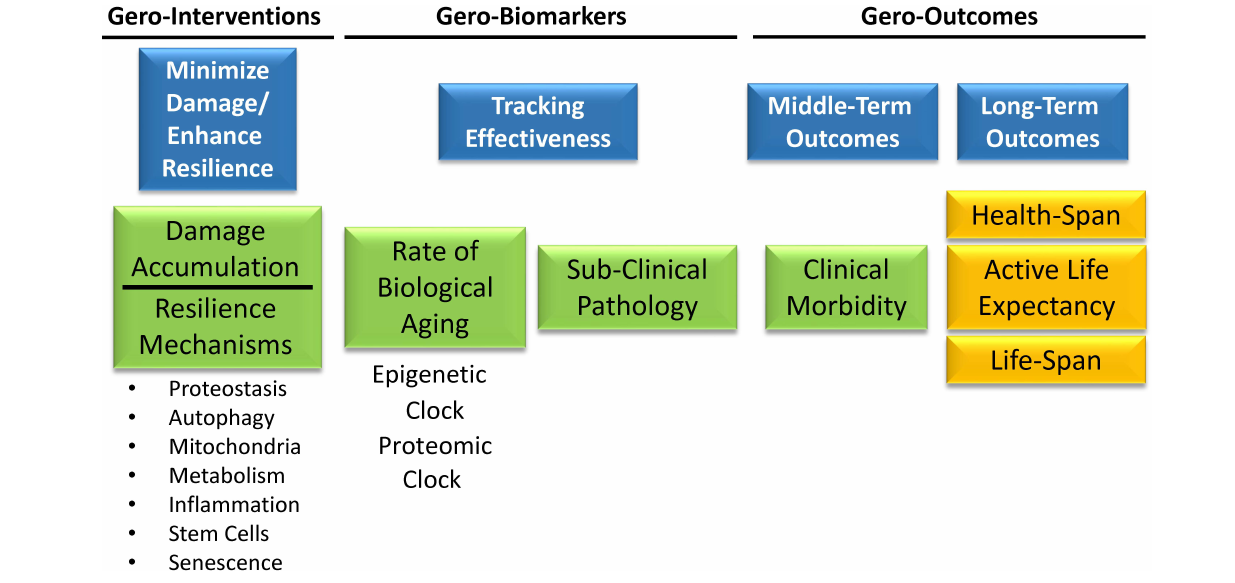
Frontiers in Physiology |